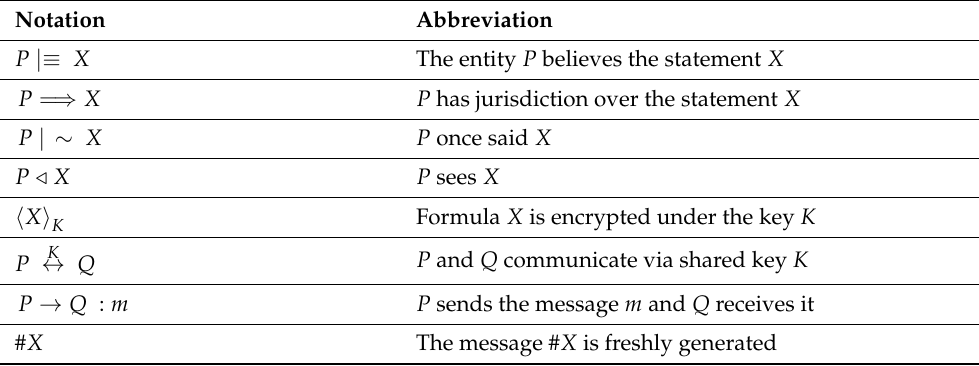
Table 2. BAN logic notations